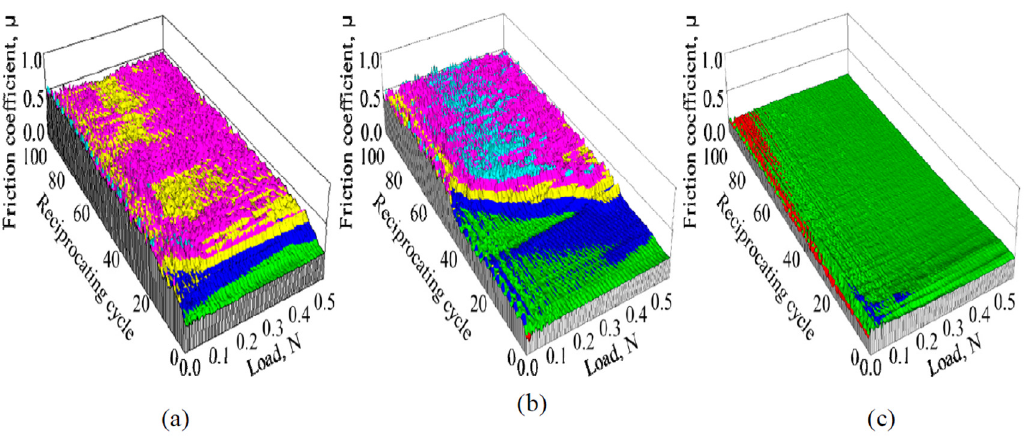
Figure 4. Friction properties of 0.4 nm P-CVD-DLC films at various temperatures. ( a ) RT; ( b ) 100 °C; ( c ) 200 °C.